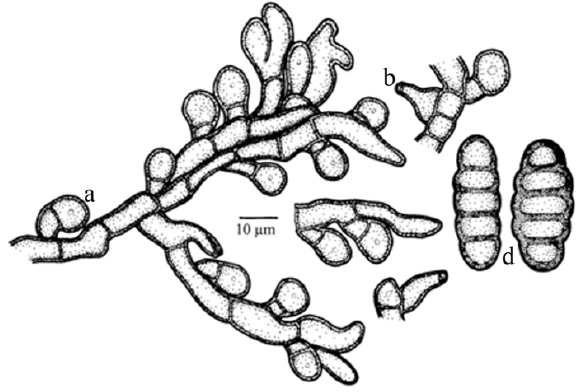
Figure 4. Amazonia peregrina a - Appressorium; b - Phialide; d - Ascospores